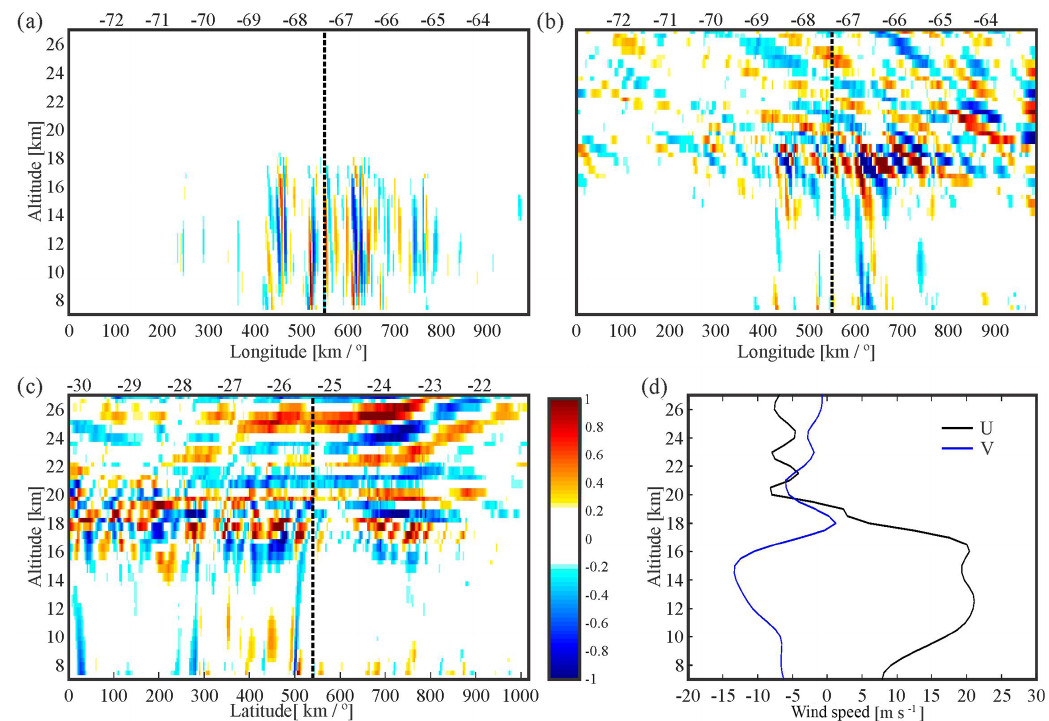
Figure 9. Simulated high-resolution GW structures in the Andes region, showing (a) δw and (b, c) δT signatures as a function of longi- tude and latitude, respectively. Non-stationary (stationary) GWs with longer (longer) horizontal wavelength and shorter (longer) vertical wavelength, above (below) the critical layer are observed. (d) Zonal and meridional mean wind.